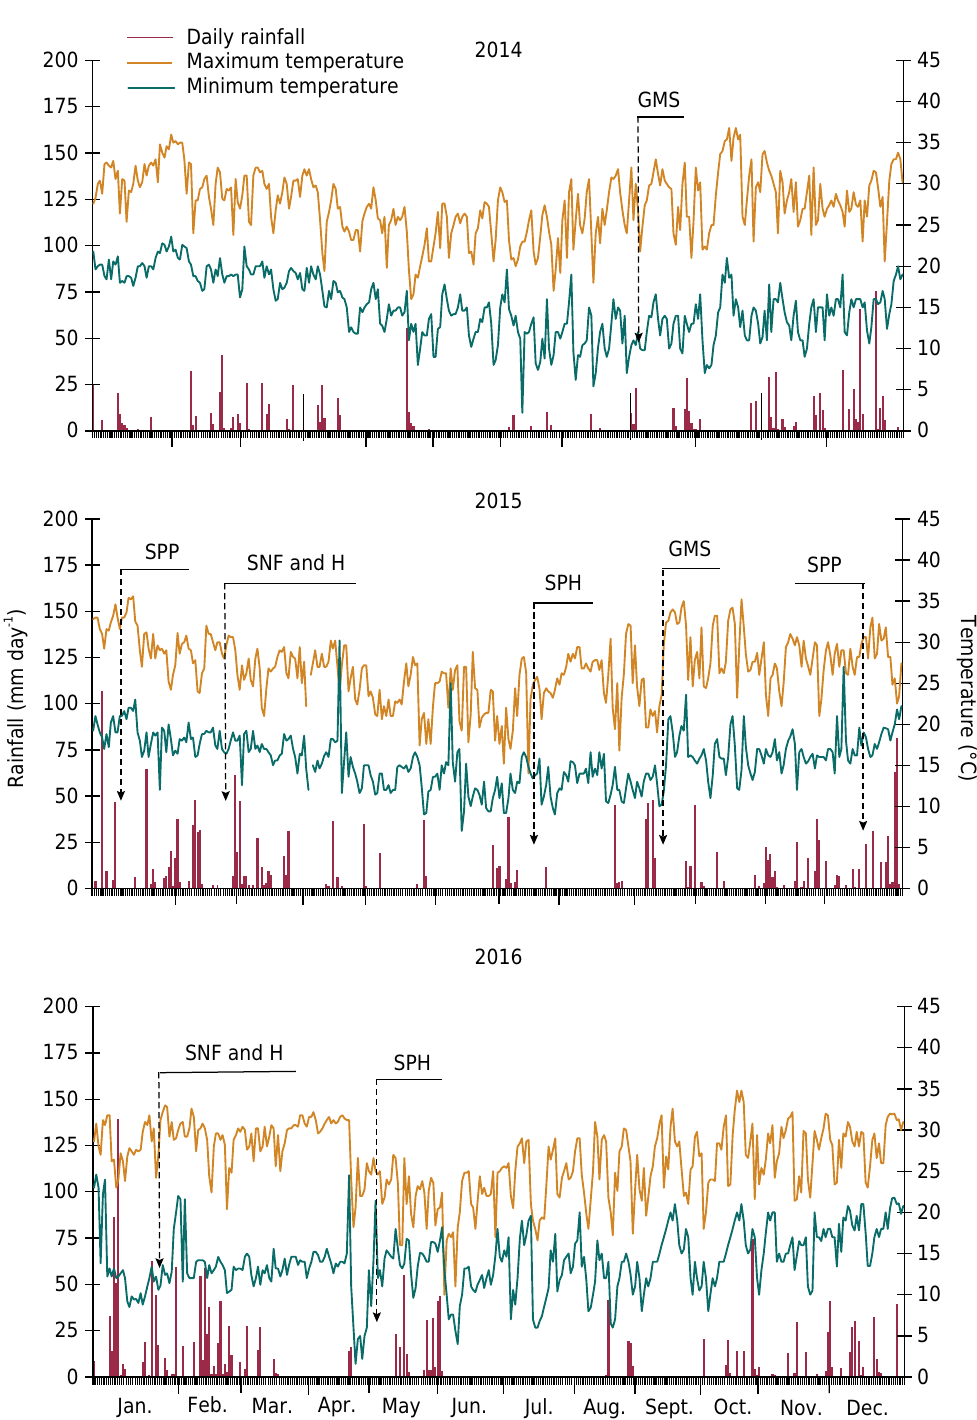
Figure 1. Daily rainfall, maximum, and minimum temperatures recorded in the field experimental area from January 2014 to December 2016 at São Paulo State, Brazil, and times of green manure sowing (GMS), sweet potato planting (SPP), side dressed N fertilization and hilling (SNF and H), and sweet potato harvest